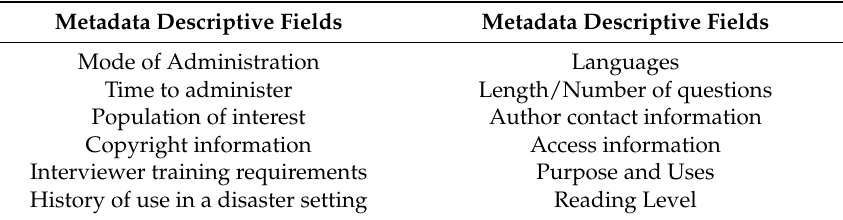
Table 1. DR2 collection tool repository: metadata descriptive